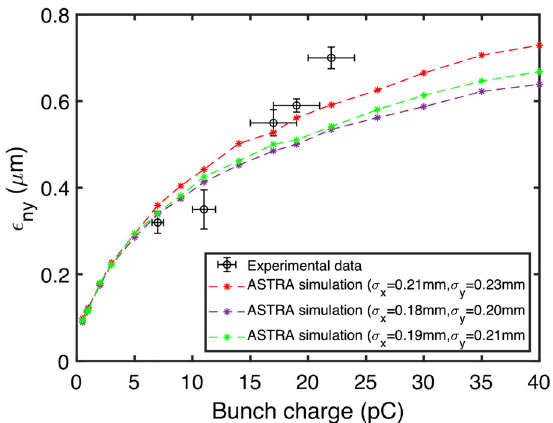
FIG. 10. Total normalized beam emittance as function of bunch charge for Y thin film on Cu substrate photocathode (y-plane): measurements (black dots) and ASTRA simulations at different laser spot size (dashed